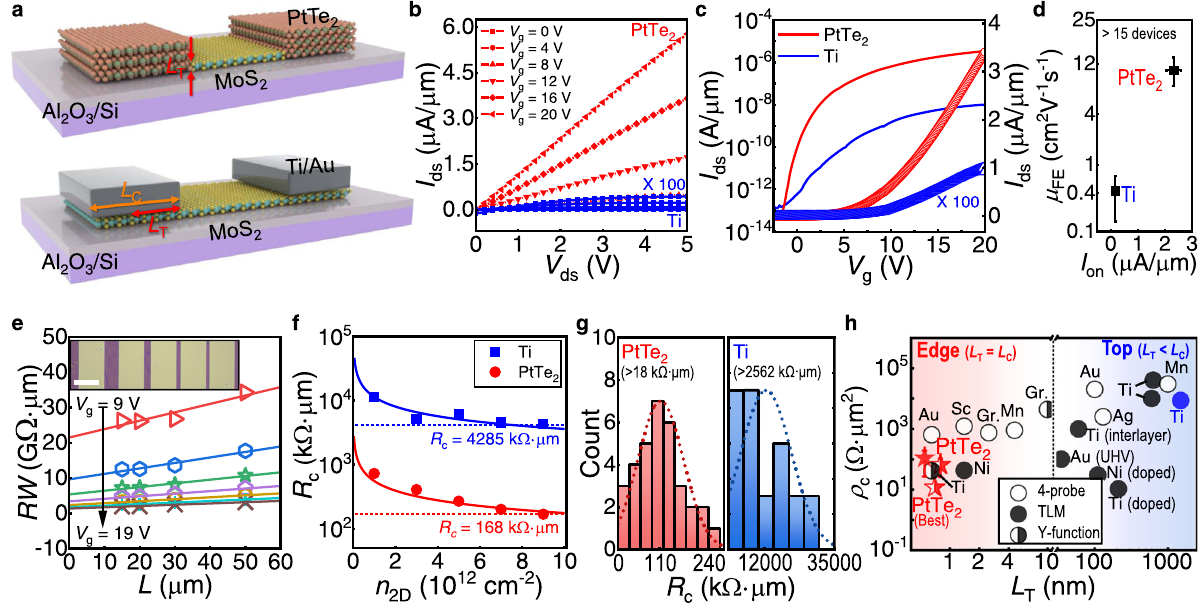
Fig. 4 | Electricaltransport studiesofthe edge-contactedPtTe 2 -MoS 2 MSJ FETs array. a Schematic showing monolayer MoS 2 FETs with patterned PtTe 2 edge contacts (upper) and vertical Ti contacts (lower). The transfer length ( L T ) of the carrier and physicallyattained contact length ( L c ) are schematicallydemonstrated. b Representative I ds – V ds characteristics of monolayer MoS 2 FET with symmetric PtTe 2 and Ti contact electrodes depending on V g . c I ds – V g characteristics of cor- responding devices on linear (symbols; right) and logarithmic scale (lines; left). d Average μ FE and I on of different FETs (>15 devices) contacted to PtTe 2 (red) or Ti (blue). The error bars indicate the standard deviations of each measurement set. e – g Determination of contact resistance ( R c ) of MSJs with different compositions using ( e , f ) TLM and ( g ) Y -function method. e TLM plot showing total resistance normalized by contact width ( RW ) asa function of L . The y -intercept y ields the 2 R c in units of Ω ∙ μ m. Inset shows OM image of MoS 2 (purple-like) grown between edges of PtTe 2 patterned for TLM. (f) TLM-derived R c of PtTe 2 -MoS 2 MSJ FETs